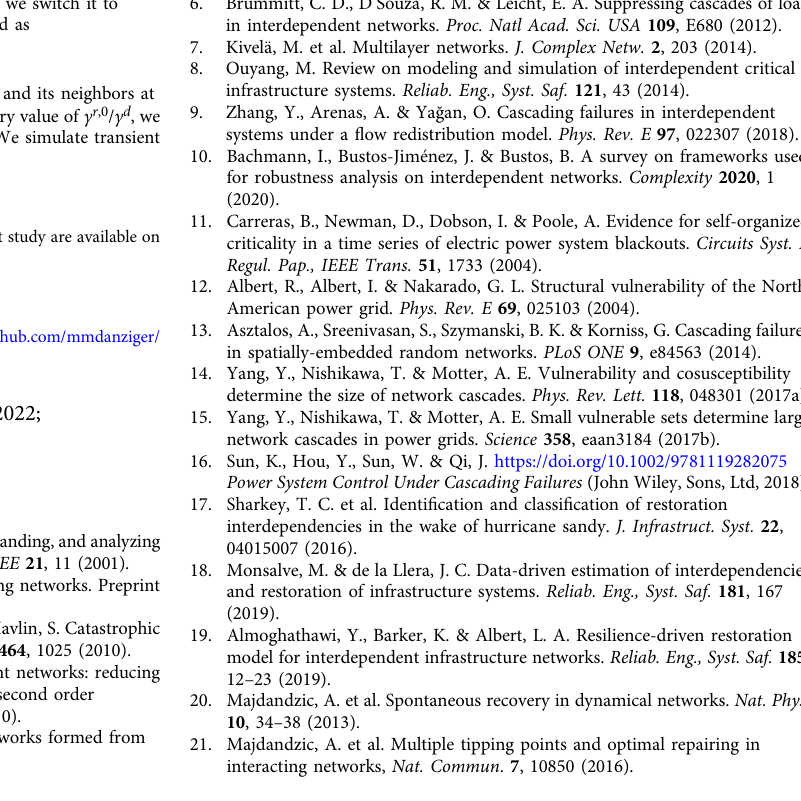
Fig. 4 Recovery coupling in multilayer networks. a Comparison between the functionality of uncoupled networks and recovery coupled networks. The uncoupled case (blue line) has a single solution for any repair to damage ratio γ r ,0 / γ d , implying that it can recover its functionality after an arbitrarily large perturbation. With recovery coupling the system can function at levels similar to the coupled case (orange line) but the non-functional collapsed state persists as an attractor (red line), implying that for suf fi ciently large damage, the system can reach a permanently collapsed state. b If we inspect the recovery per unit time as a function of concurrent damage amount, we observe a behavior similar to elasticity in materials science. Recovery coupling leads to a sublinear or inelastic behavior, predicting the loss of resilience under heavy damage. c The elastic residual plot from bidirectionally coupled random networks shows the same pattern as observed for the real data in Fig.